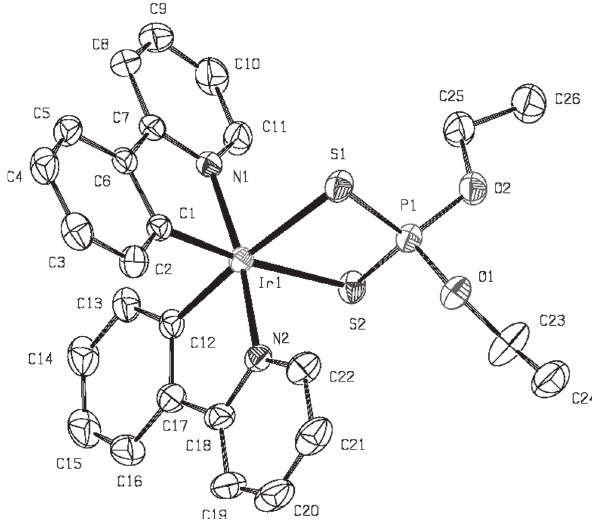
Table 1: Data collection and